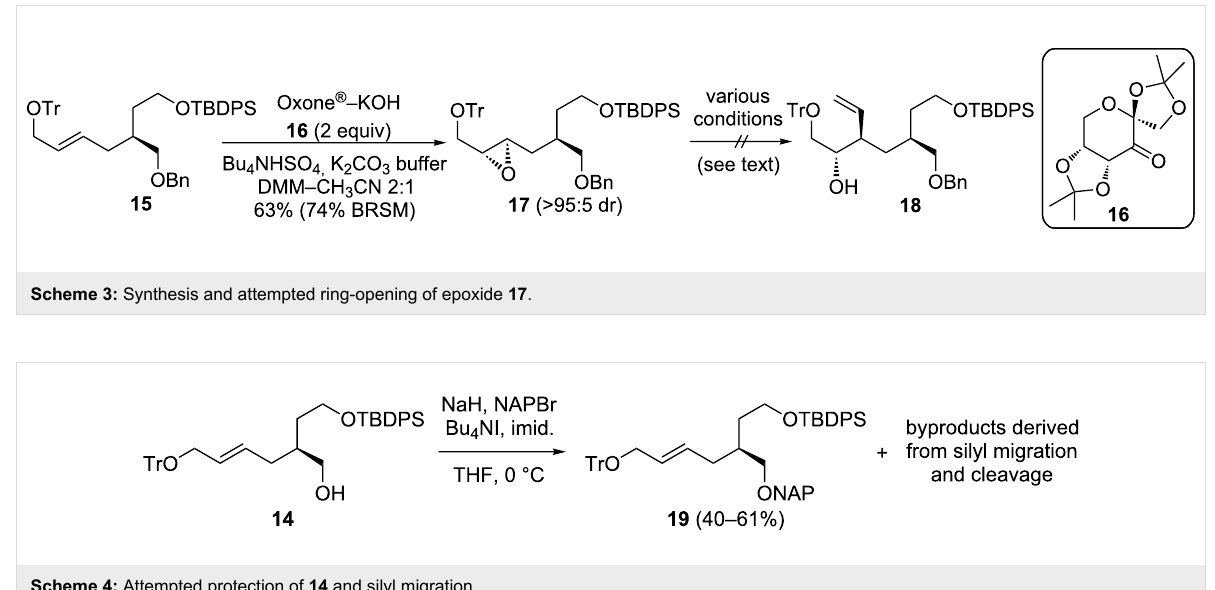
Scheme 4: Attempted protection of 14 and silyl